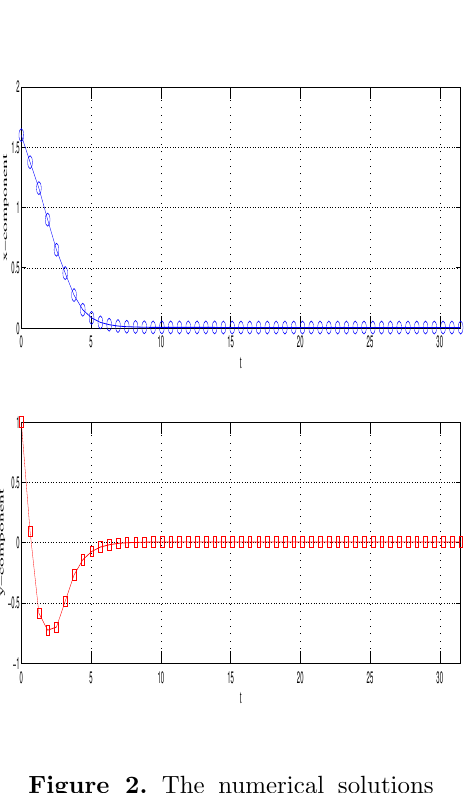
Figure 4. The numerical solutions obtained by the NSFD scheme with h = 0 . 8 after 50 iterations in Exam- ple